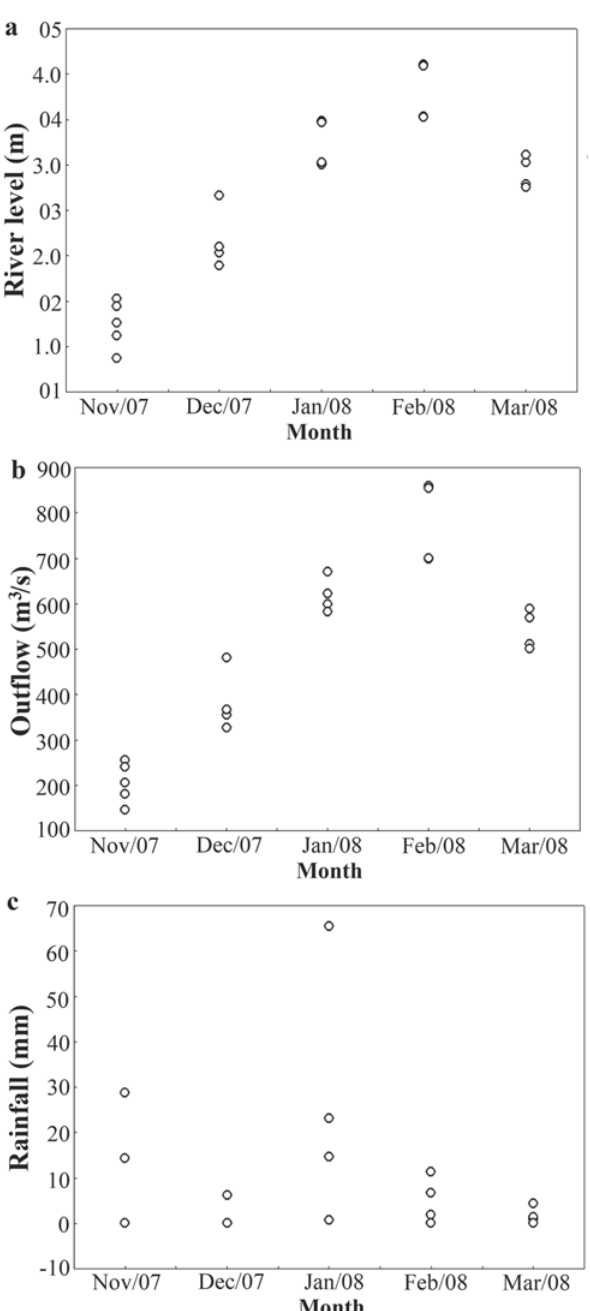
Fig. 3. Values of the regional variables of river level ( a ), outflow ( b ), and rainfall ( c ), obtained in the region of Rosario Oeste between November 2007 and